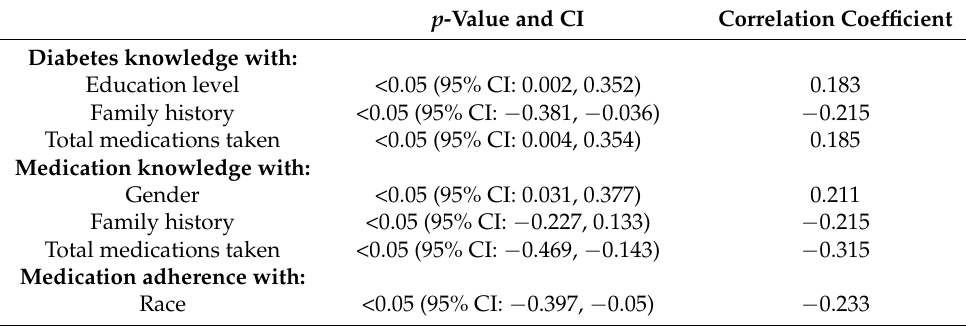
Table 3. The significant relationship between the